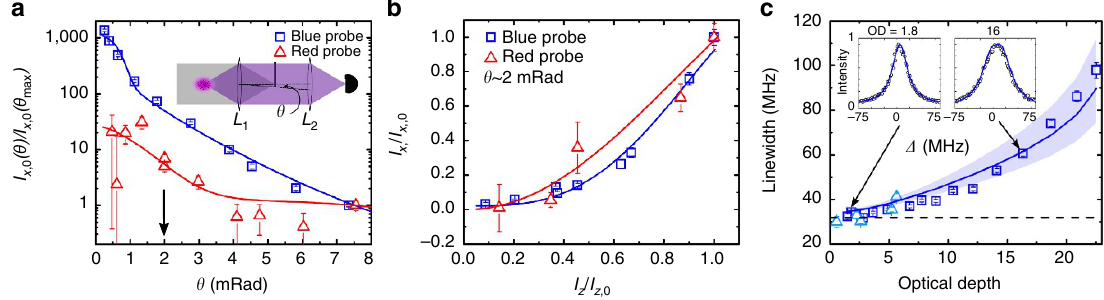
Figure 2 | Forward scattering. ( a ) Comparison of forward scattering intensity versus angle using a red and blue probe beam. We use the setup shown in the inset, to block the probe beam. After interacting with the atoms the probe beam is focused using a lens, which also collimates the fluorescence from the atoms. We block the probe beam using a beam stopper, which we translate perpendicular to the probe beam, to change the angular range of fluorescence collected by the detector, characterized by the angle ( y ) between ^ x and the edge of the beam stopper (see Methods). The measured intensity, I x ,0 ( y ), for each probe beam is normalized to the intensity at y max ¼ 7.5mRad. The dephasing caused by motion reduces the forward intensity peak for the red transition. ( b ) Comparison of intensity in the forward direction, I x , versus intensity in the transverse direction, I z . Both are varied by changing N . All measurements are made at y ¼ 2mRad (arrow in a ) and normalized to the intensity, I x ,0 , for the atom number used in a . ( c ) Linewidth broadening in the forward direction measured by scanning the blue probe beam detuning, D , across resonance. Example lineshapes for different ODs are shown in the inset. Two different atom numbers are used, N ¼ 1.7(2) (cid:3) 10 7 (blue squares) and N /4 (cyan triangles). The dashed line represents G for reference. All solid curves are based on the full theory of coupled dipoles and the band in c is for a ± 20% atom number uncertainty. All error bars are for statistical